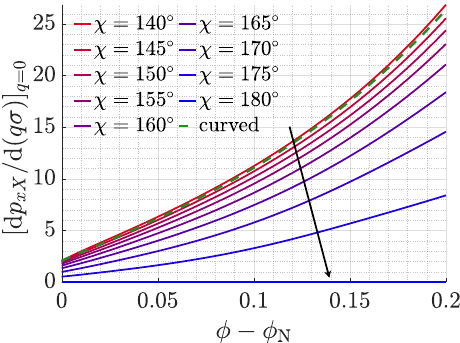
Figure 8. Slope of the transversal polar order parameter induced by a bend deformation, p xX ( q ) , calculated at q = 0, as a function of the packing fraction difference φ − φ N , for acute angle V-shaped particles with different values of the bend angle. φ N is the packing fraction in the nematic phase at the nematic-isotropic boundary. The dashed line shows the results for the curved particle shown in Figure 2c. Positive p xX values mean that the apex of a V-shaped particle preferentially points to the opposite direction of the center of a bend